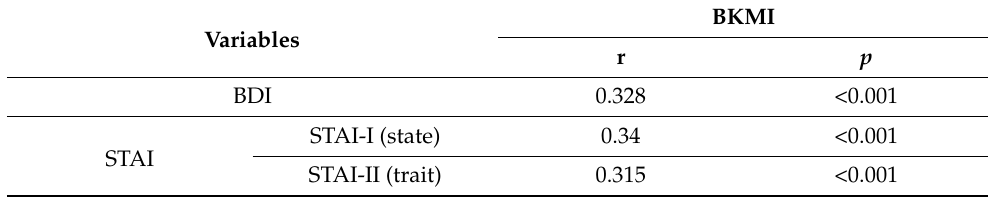
Table 5. Correlations between climacteric symptoms and psychosocial functioning variables (depres- sion according to the BDI, anxiety according to the